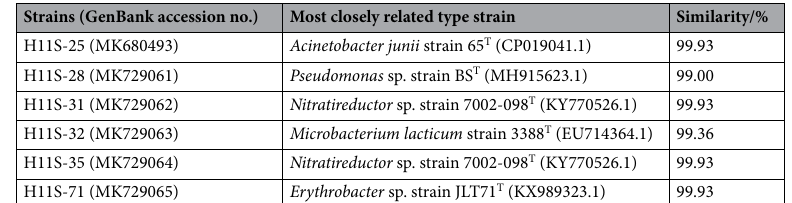
Strains (GenBank accession